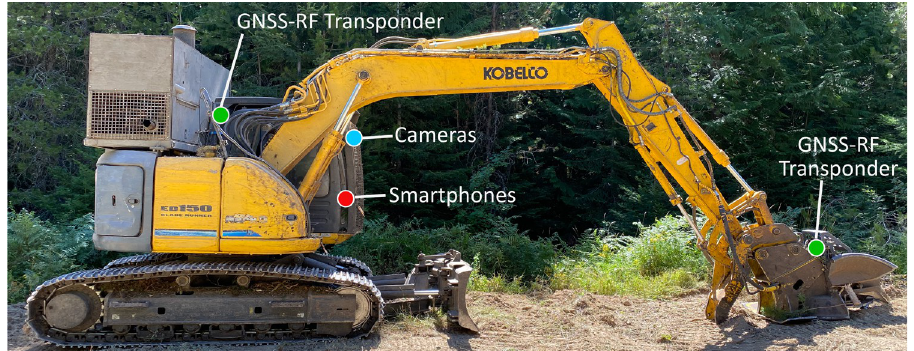
Fig 1. Smartphone, camera, and GNSS-RF transponder device locations on the